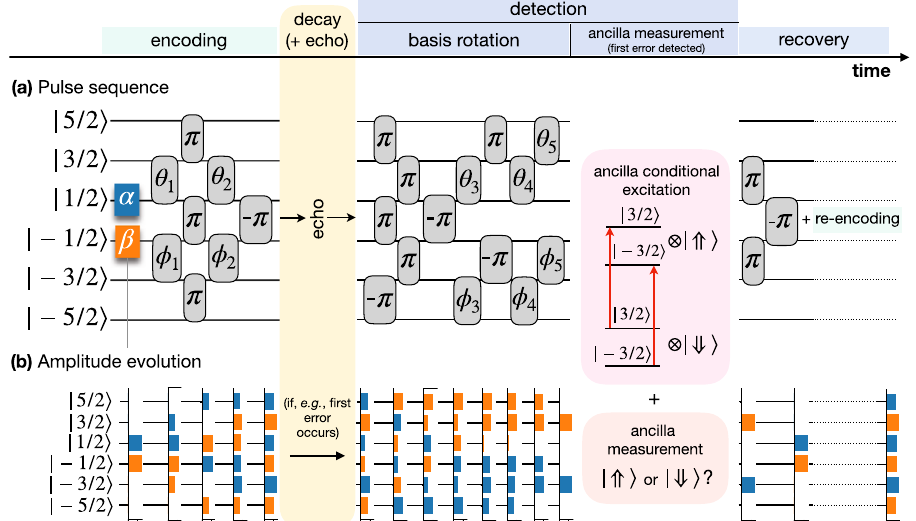
Fig. 6 Pulse sequence for S = 5/2. a Explicit sequence of pulses to implement the QEC for a spin S = 5/2. Each horizontal line represents a spin state m j i with time fl owing from left to right. Each grey box indicates a pulse implementing a rotation Y m ( θ ) as described in the text, with the values of the angles θ k and ϕ k given in Table 1. b Time evolution of the absolute value of the amplitude j m j ψ ð t Þjh ij of the qudit state ψ ð t Þj i over each m j i state at different stages of the control sequence, corresponding to the control pulses depicted in ( a ). The sequence holds for any choice of α and β , though panel ( b ) shows an example with α ¼ 1 = to α and β (i.e., 0 L j i and 1 L j i ), respectively. To exemplify the effect of the basis rotation and the outcome of the measurement during the